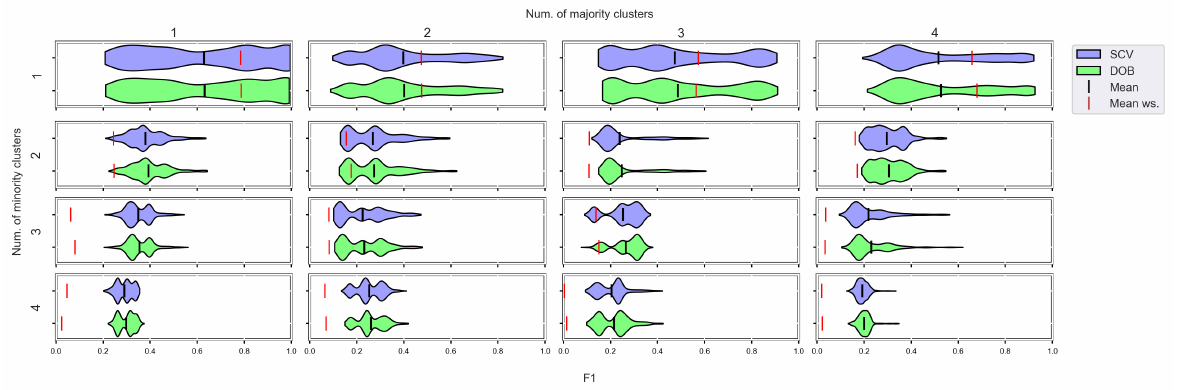
Figure A12. F 1 values concerning the number of clusters in the minority and majority classes in the case of the SVM classifier. (IR16).